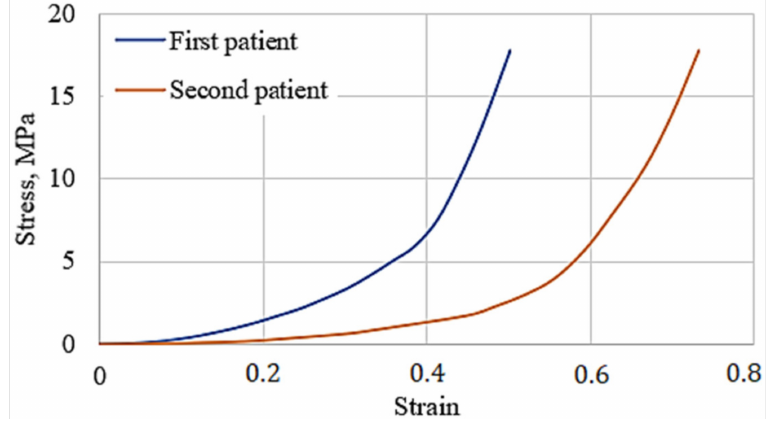
Figure 3. Stress–strain curves of the human meniscus.